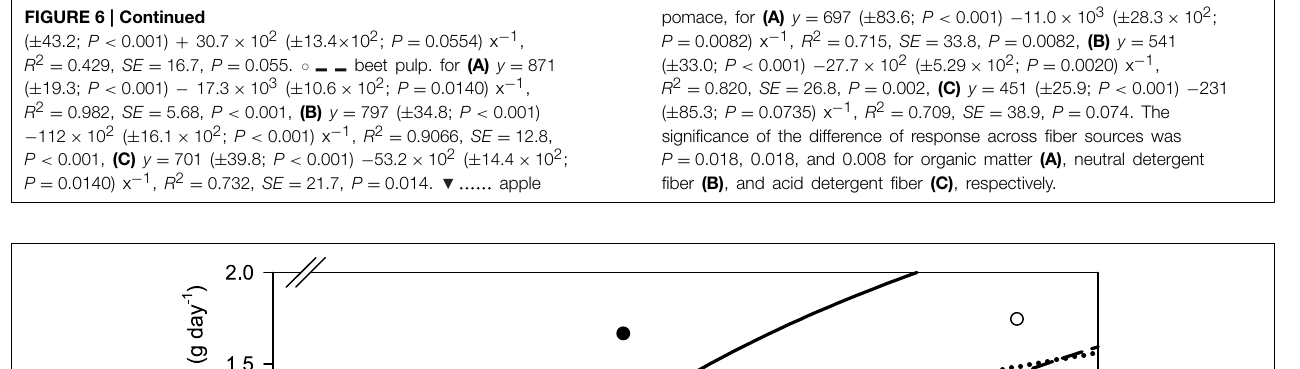
FIGURE 7 | Relationship between the amounts of organic matter degraded and rumen-degradable protein. ● brachiaria hay, y = 4 . 18 ( ± 1.09; P = 0 .0064) − 16.8 ( ± 5.57; P = 0 .0194) x − 1 , R 2 = 0 . 566 , SE = 2 . 23 , P = 0 .019; ○ beet pulp, y = 3 . 80 ( ± 0.666; P = 0 .0023) −